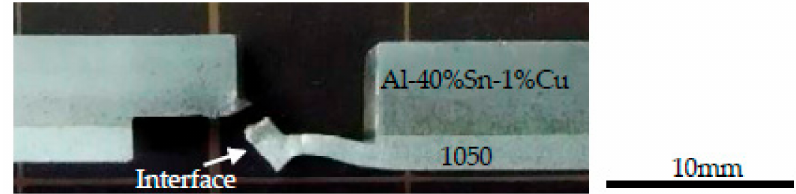
Figure 28. Test piece of tensile-shear test after test.